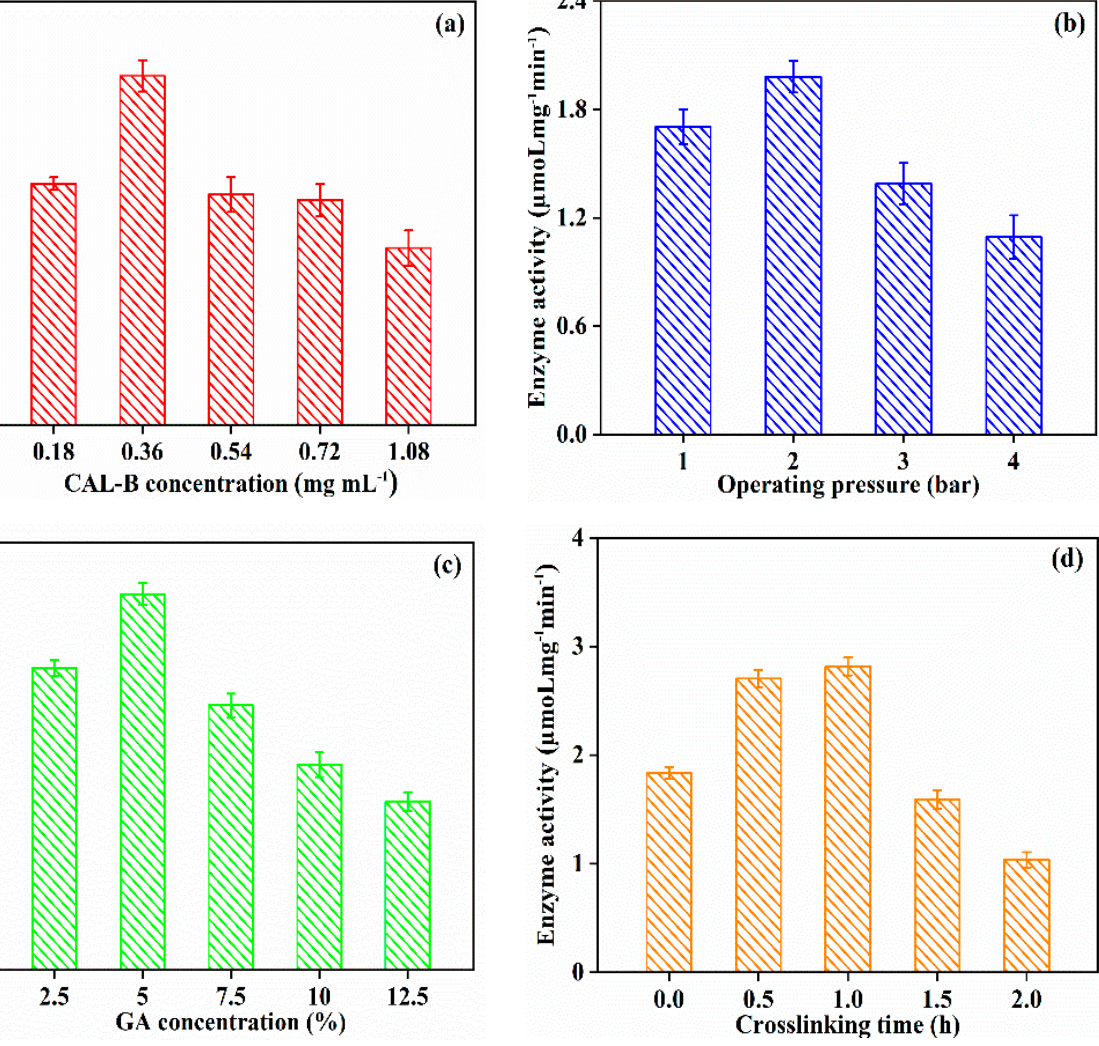
Figure 7. Enzyme activity of GA/CAL-B@PDA/PES at different fabrication operating conditions: ( a ) CAL-B concentration, ( b ) operating pressure, ( c ) GA concentration, and ( d ) crosslinking time.